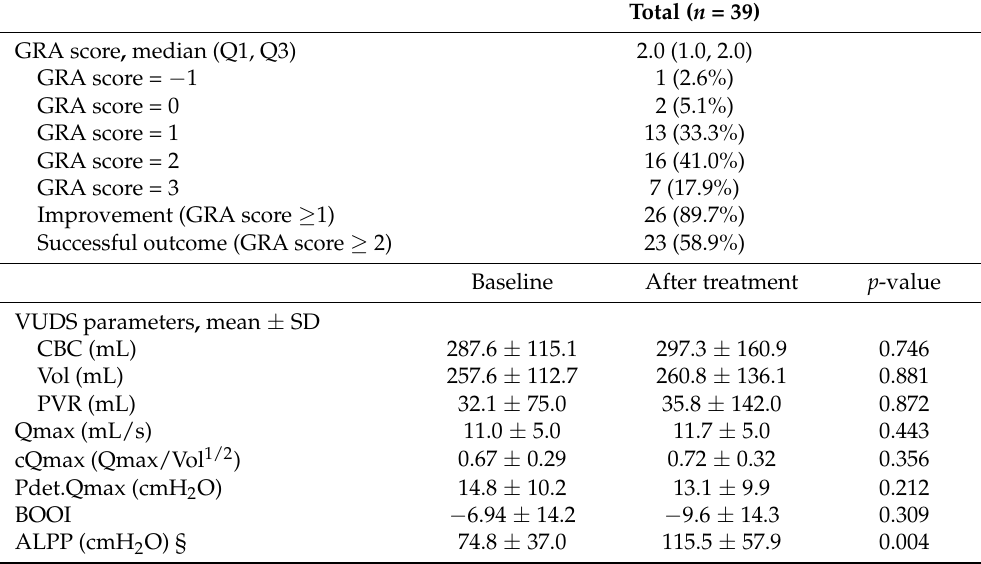
Table 2. Clinical outcomes and change in urodynamic parameters after platelet-rich plasma urethral sphincter injection